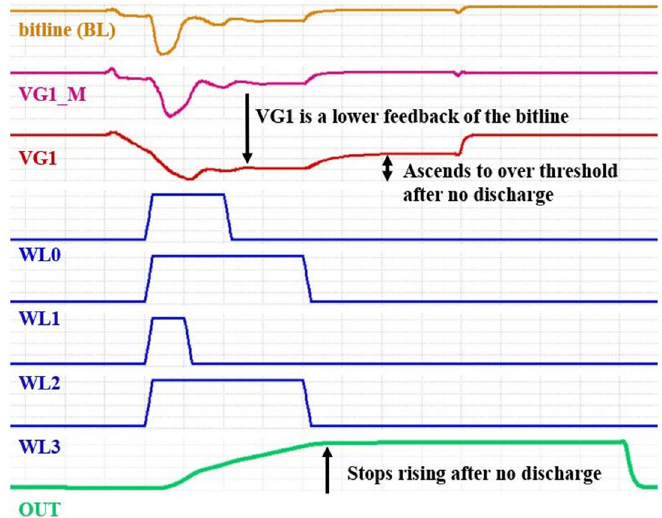
Figure 3. Waveform of the multi-row read operation with the proposed compensation circuit.